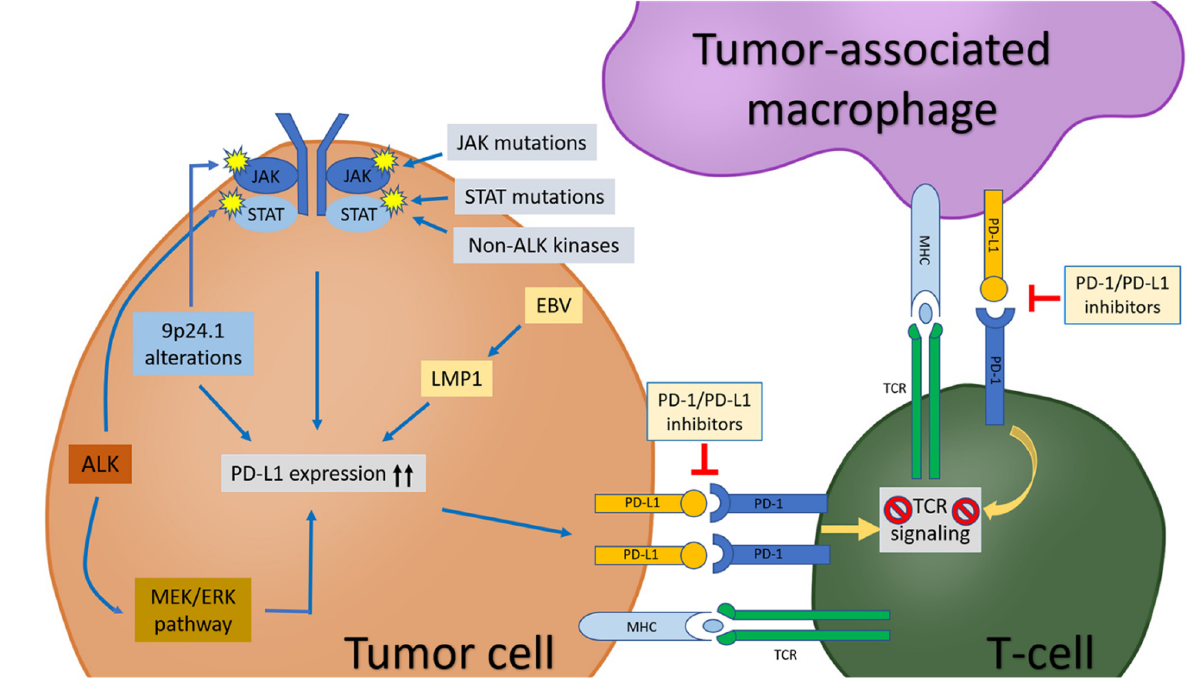
Figure 1. The PD-1/PD-L1 pathway in tumor cells, tumor-associated macrophages (TAMs), and T- cells in tumor microenvironment. PD-L1 expression in tumor cells is upregulated by: (1) chromosome locus 9p24.1 alterations (polysomy, copy gain, amplification, translocation, etc.); (2) activation of JAK/STAT pathway due to chromosome locus 9p24.1 alterations, kinases (such as ALK and non- ALK), JAK/STAT mutations; (3) EBV infection; (4) MEK/ERK pathway. PD-L1 on tumor cells and/or TAMs interact with PD-1 on T-cells, leading to inhibition of T-cell receptor (TCR) signaling pathway and subsequent T-cell “exhaustion”. Blockade of the PD-1/PD-L1 pathway can release T-cells from the inhibitory effects by tumor cells and/or TAMs and re-establish the T-cell-mediated antitumor immune response.